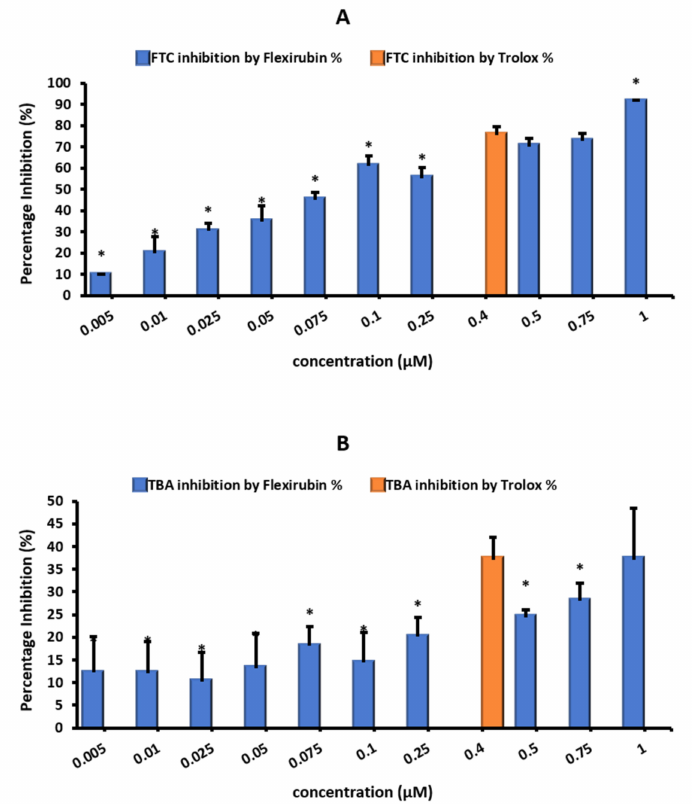
Figure 5. Inhibition of lipid peroxidation by flexirubin extract at different concentrations (0.005–1 µ M) using two methods. ( A ) ferric thiocyanate (FTC) method. ( B ) Thiobarbituric acid (TBA) method. Each point represents the mean ± SD ( n = 3); * shows statistically significant differences at p ≤ 0.05 in the observed activities when compared with that of Trolox